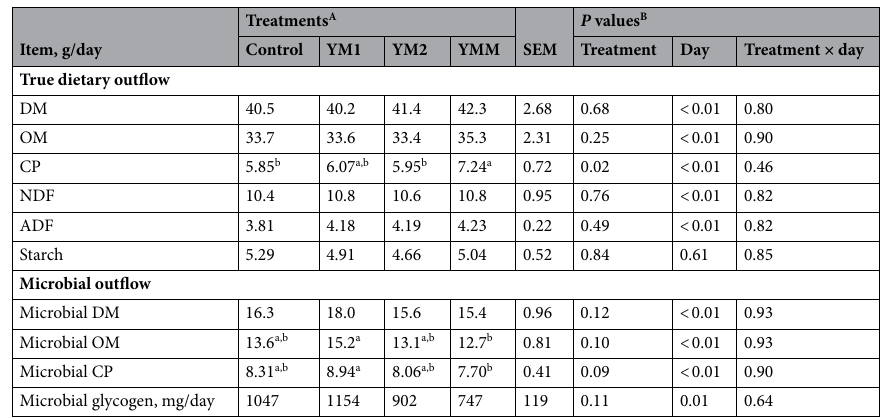
Table 1. Effects of direct-fed microbials (DFM) on true nutrient and microbial outflow in dual-flow continuous culture system (DM basis). A All treatments had the same basal diet (1 mL of each DFM was applied per day at 1 × 10 8 cfu/mL); treatments were: Control, carrier of additives without DFM; YM1, S. cerevisiae and M. elsdenii strain 1; YM1, S. cerevisiae and M. elsdenii strain 2; YMM, S. cerevisiae and M. elsdenii strain 1 (1/2 dose) and strain 2 (1/2 dose). B Statistical differences were declared at P ≤ 0.05 or as a trend to be different if P > 0.05 and <